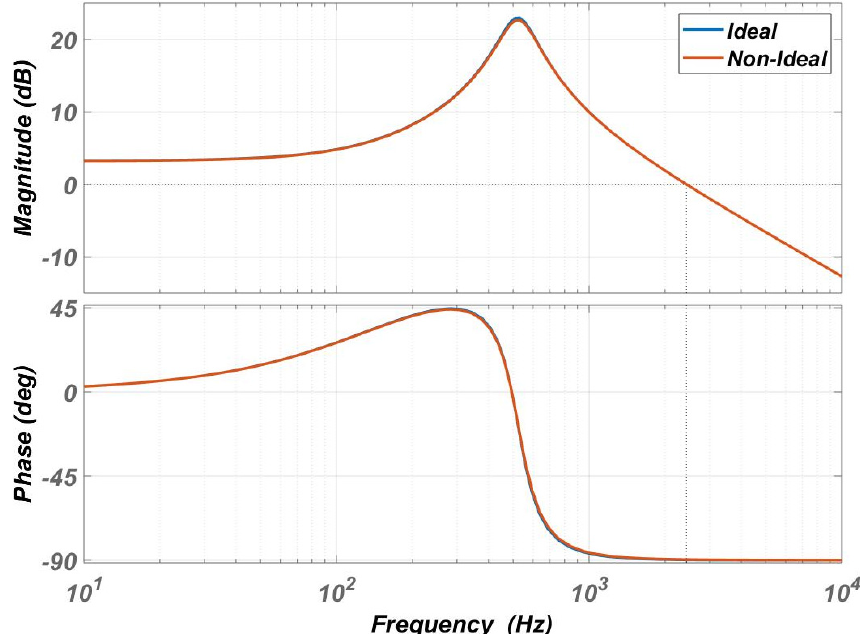
Figure 9. Bode plot of G id for ideal and non-ideal synchronous buck converters.